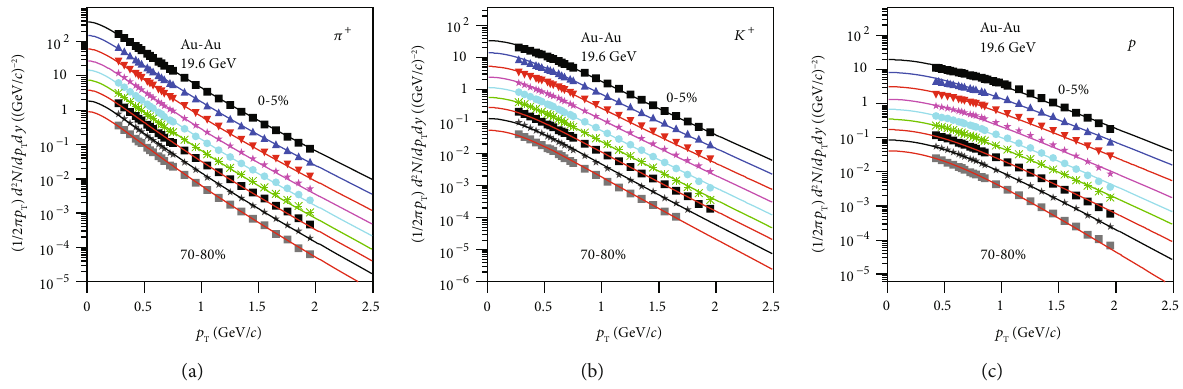
ffiffiffiffiffiffiffiffiffi p = 19 : 6GeV s NN